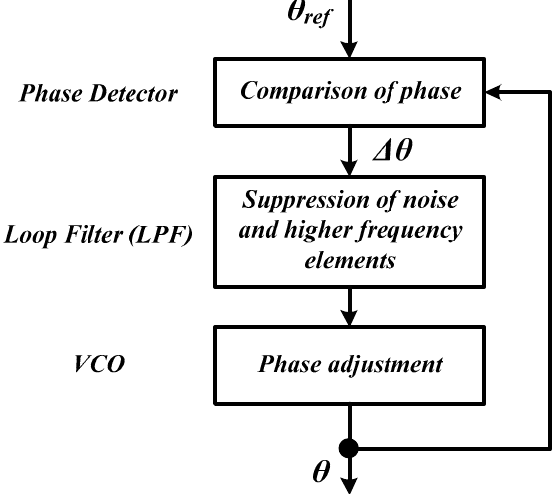
Figure 4. Control structure of a basic phase-locked loop (PLL) technique [72]. VCO: voltage-controlled oscillator.